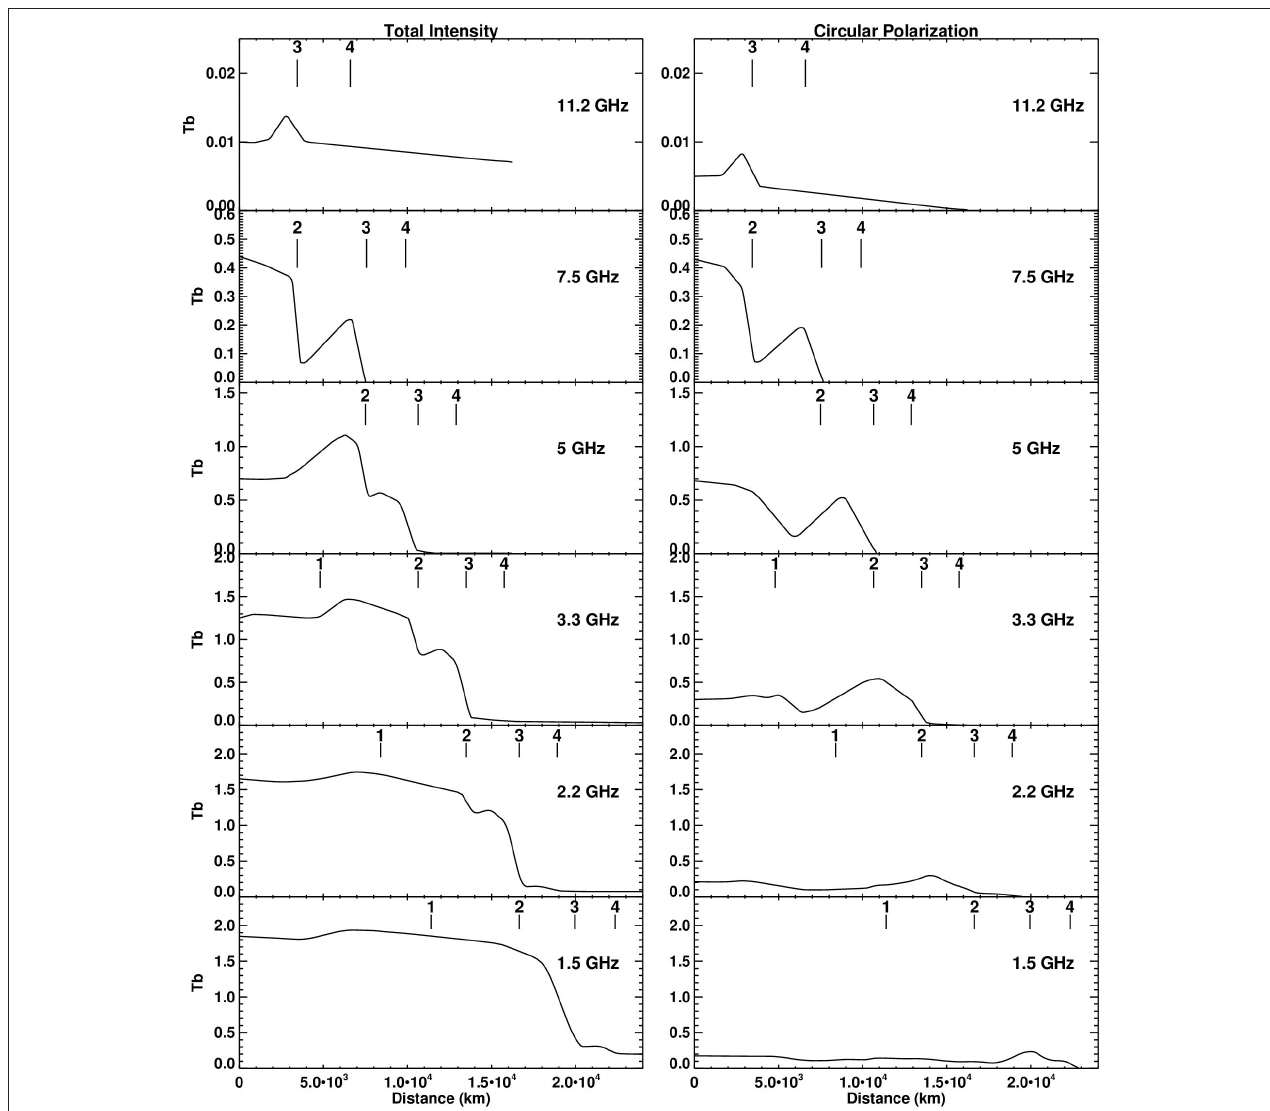
FIGURE 8 | Brightness temperature (in units of million degrees Kelvin) in I (left) and V (right) as a function of distance from the center of the dipole sunspot model of Figure 7 , calculated from the radio models of Figure 7